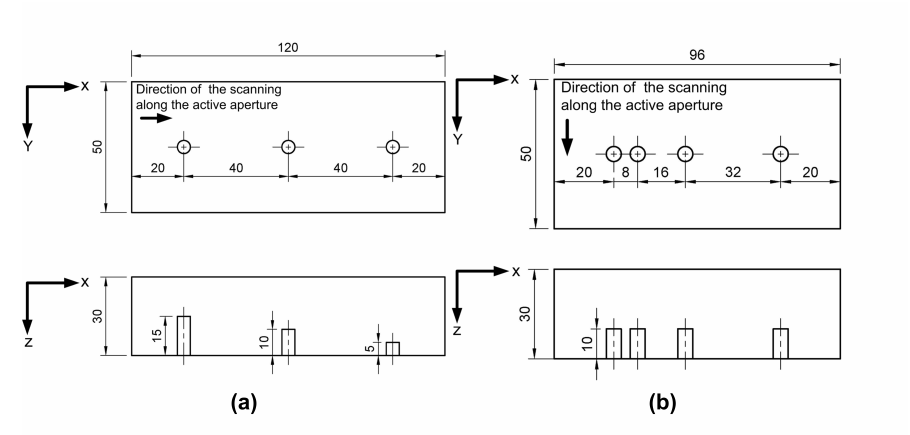
Figure 6. Location of the defects in blocks ( a ) A, B and C and ( b ) block